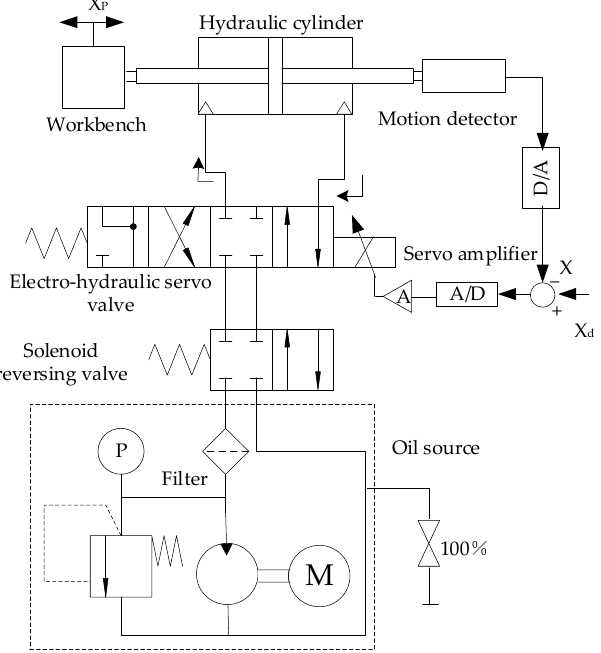
Figure 1. Schematic diagram of a typical electro-hydraulic position servo system.